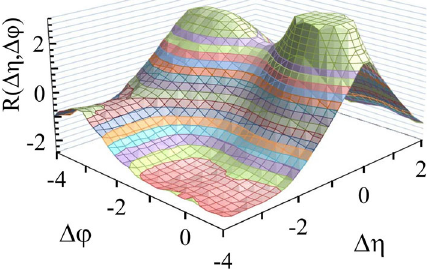
Fig. 3 The R (Δη,Δϕ) distribution simulated with FANSY 2.0 QGSJ at | Δη | ≤ 4 for high-multiplicity events